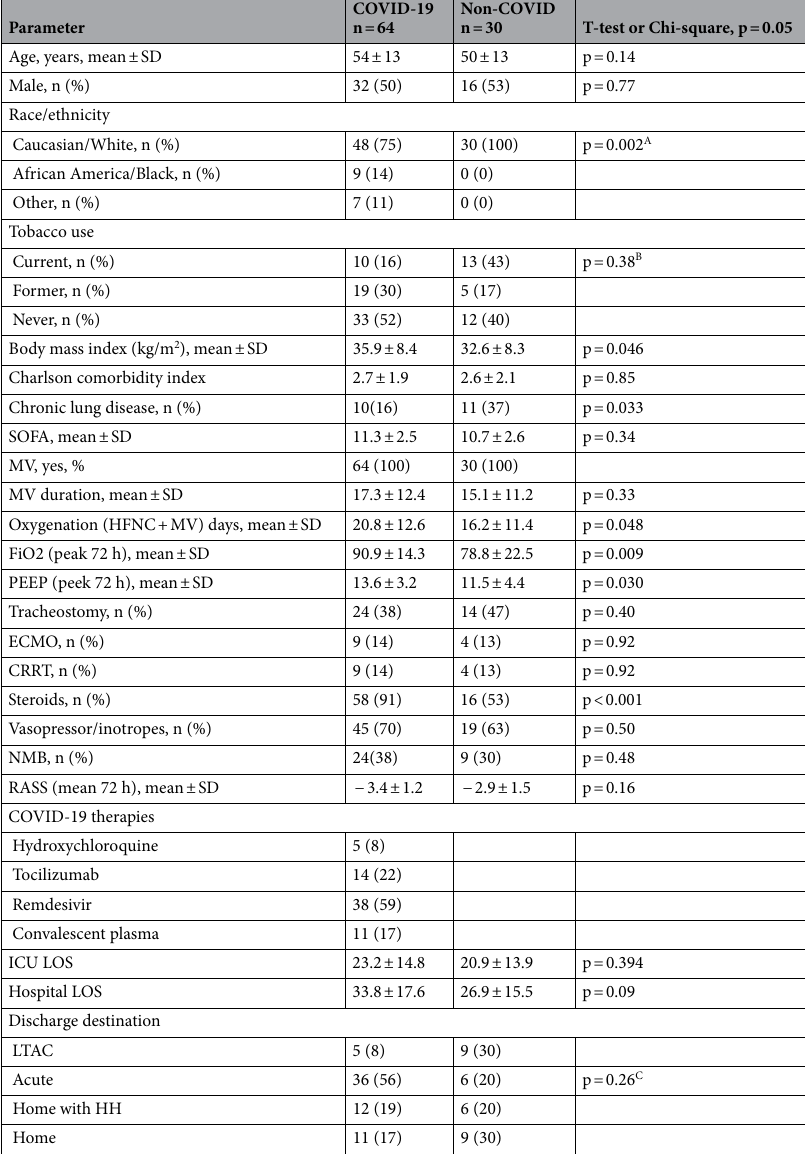
Table 1. Demographic and clinical data for patients surviving ARDS. SOFA sequential organ failure assessment, MV mechanical ventilation, FiO2 fraction of inspired oxygen, PEEP positive end expiratory pressure, ECMO extracorporeal membrane oxygenation, AKI acute kidney injury, CRRT continuous renal replacement therapy, NMB neuromuscular blocker, RASS Richmond Agitation Sedation Scale. A Fisher’s exact test assessing Caucasian/White vs combined African American/Black and Other. B Fisher’s exact test assessing combined Current and Former vs Never tobacco use. C Fisher’s exact test comparing discharge to Home + Home with HH compared to discharge to facility (acute +